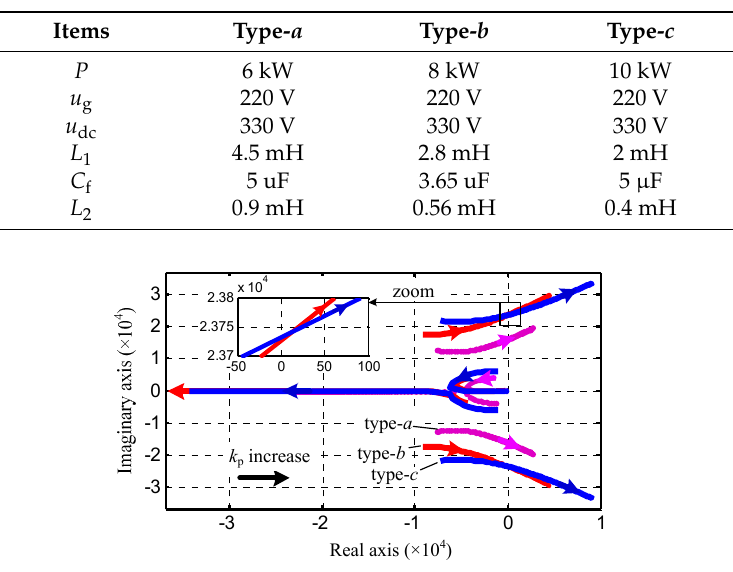
Table 1. System main parameters.